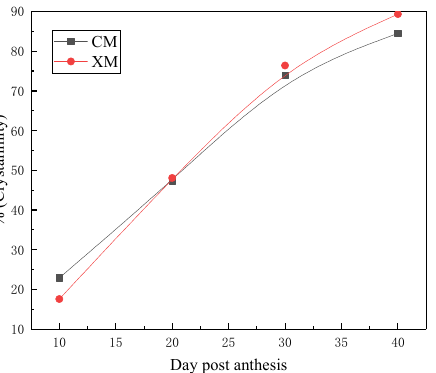
Figure 3. X-ray diffraction patterns of fibers harvested from ( a ) CM and ( b ) XM.